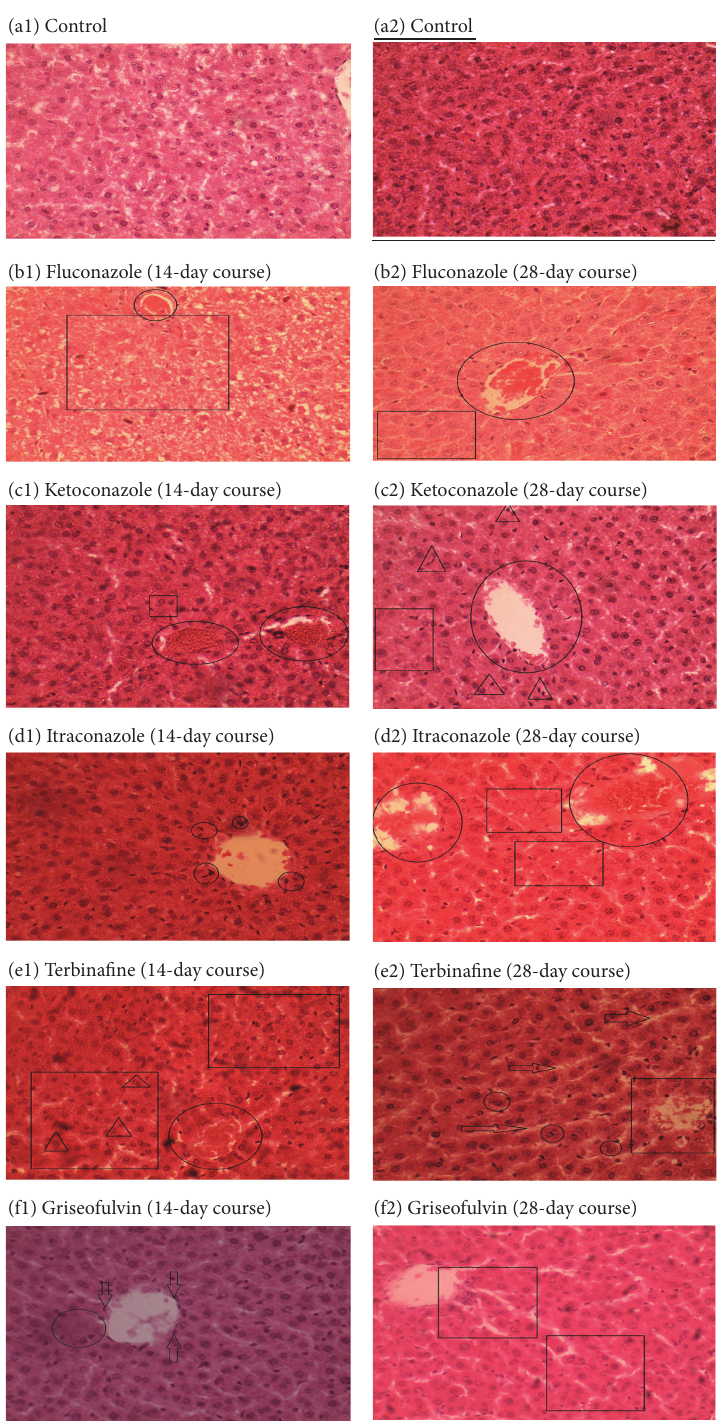
Figure 2: Photomicrographs of liver sections of the control group (a) and after 14- and 28-day courses of fluconazole (b), ketoconazole (c), itraconazole (d), terbinafine (e), and griseofulvin (f). (a) Normal lobulation with clear outlines, normal cells with visible outlines, and single nuclei. (b) In 14-day plate the rectangular area shows a marked reduction of cell numbers in the perivenular area. Circular areas indicate infiltration of venules by leukocytes. 28-day course plate shows reduced cellular density similar to 14-day plate. (c) Rectangular area indicates reduced cell density; circular areas indicate perivenular region with minor necrotic figures, that is, dark spots on plate. Triangular region indicates scattered necrotic foci (28-day course). (d) Minor venular distortion indicated by the circular demarcations here; triangular areas show apoptotic cells. Rectangular area shows reduced cell density. (e) Rectangular area shows paucity of cells; circular areas show clustering of cells which is a possible indication of stress. (f) Rectangular areas show a reduction in cell numbers and tissue striations (28d). Perivenular cell paucity is indicated by the circular area on the plate (14d). Also apparent are necrotic foci around the central venue (arrows). All plates are × 200